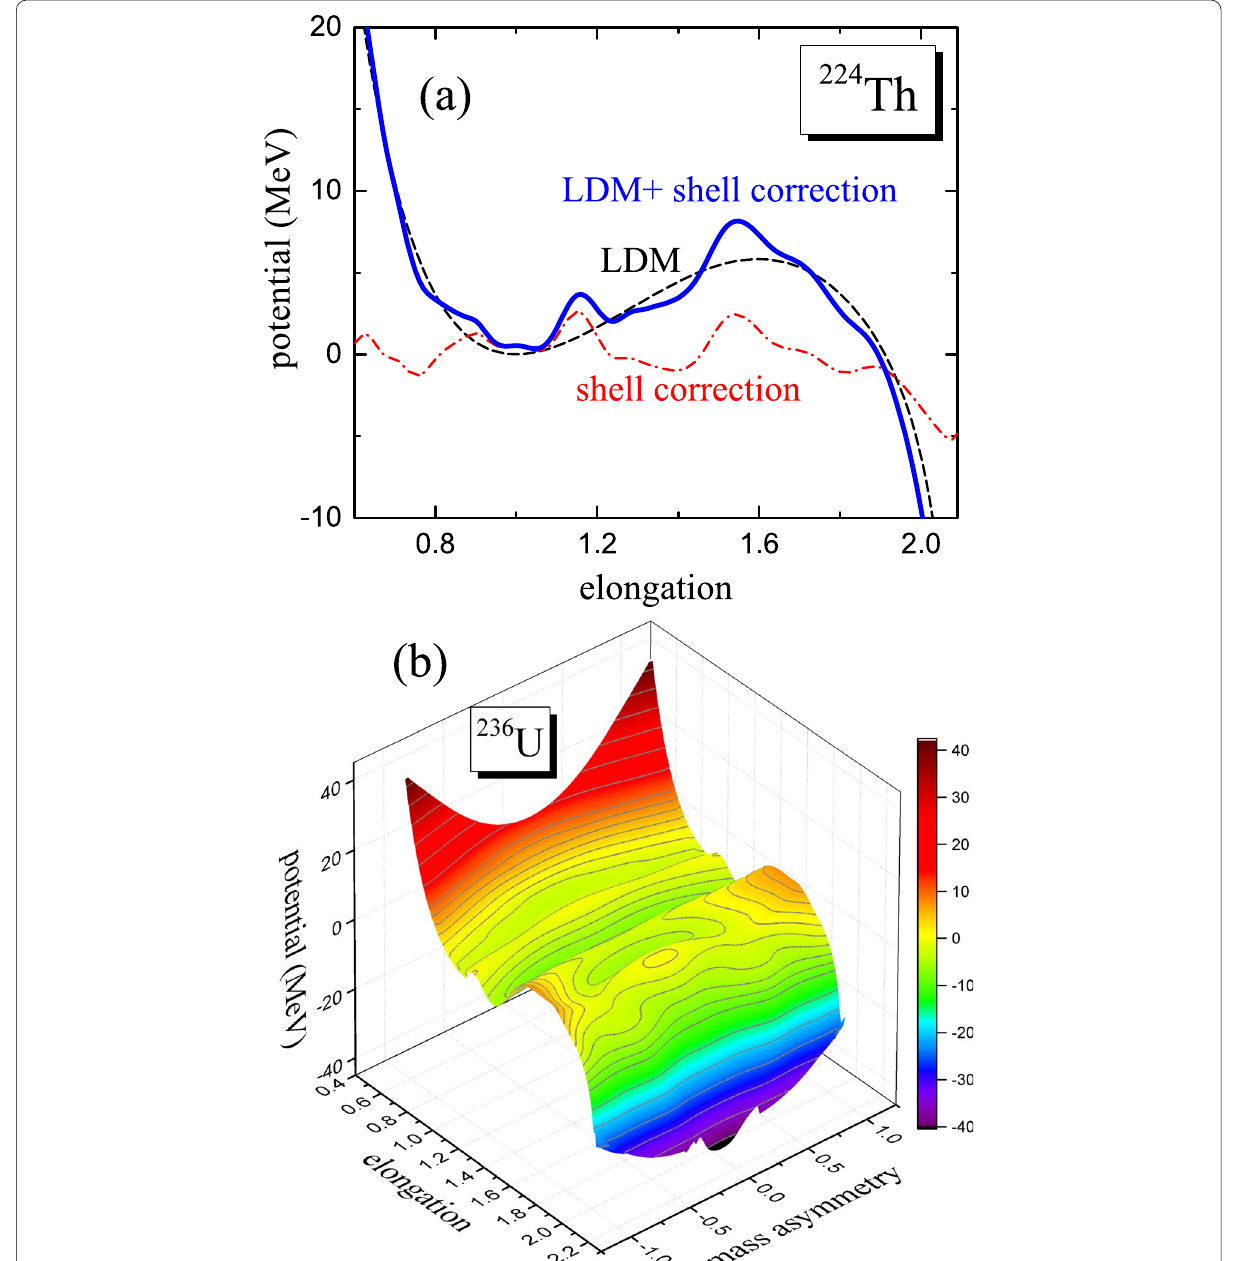
Fig. 2 a Potential profile (solid line) of 224 Th after adding shell correction (dash-dotted line) to the liquid drop potential (dashed line). b Two-dimensional potential energy surface of 236 U obtained within the mac-mic